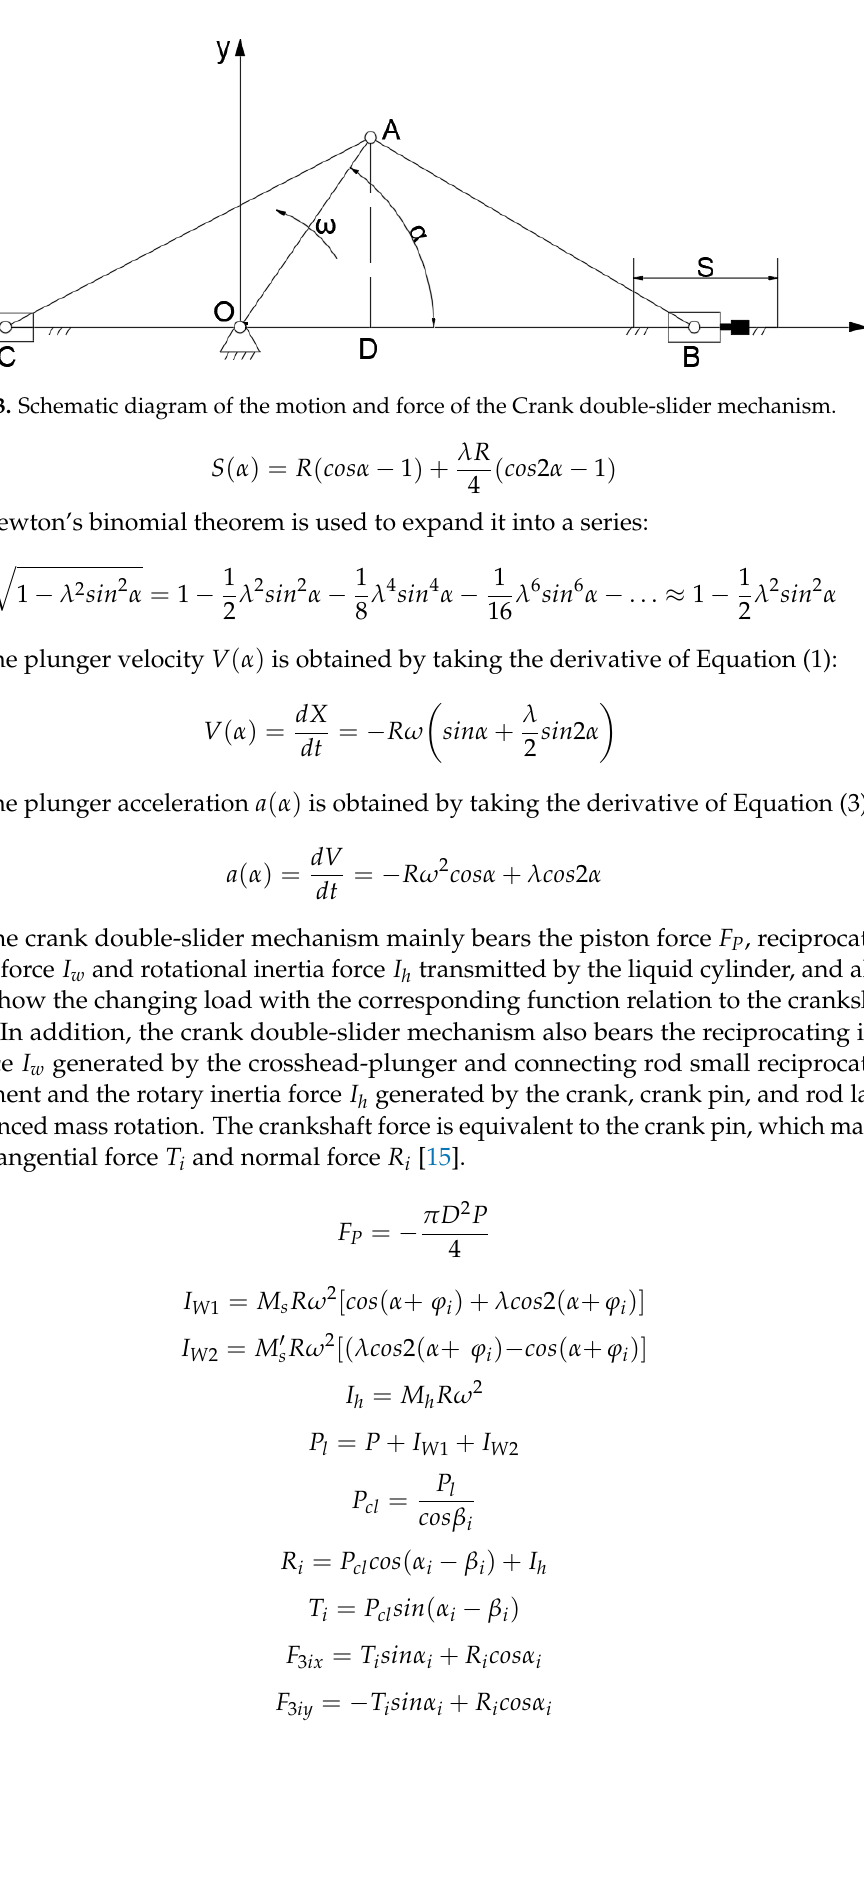
5 of 22 Table 1. Seven opposed plunger pump structure and working parameters. Description